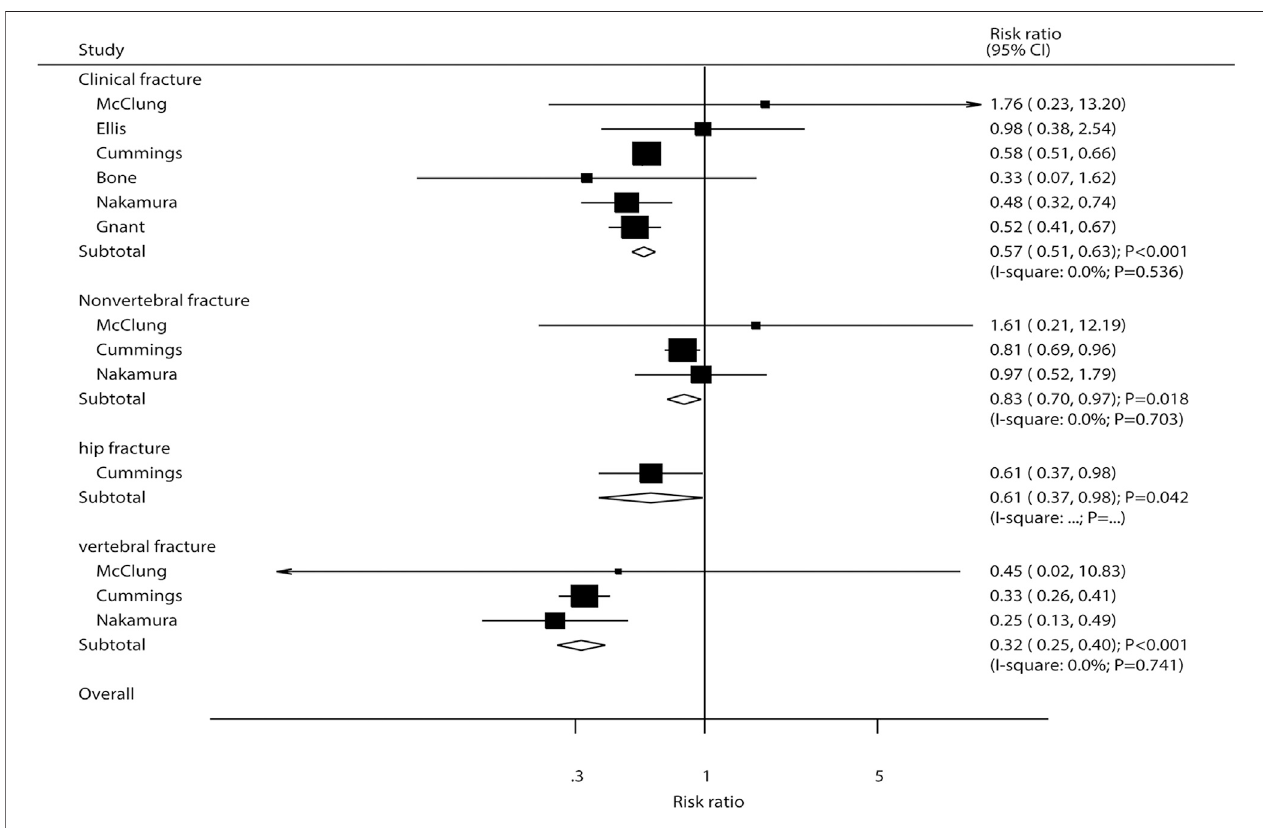
FIGURE 3 | Summary results of fracture risk at various sites.